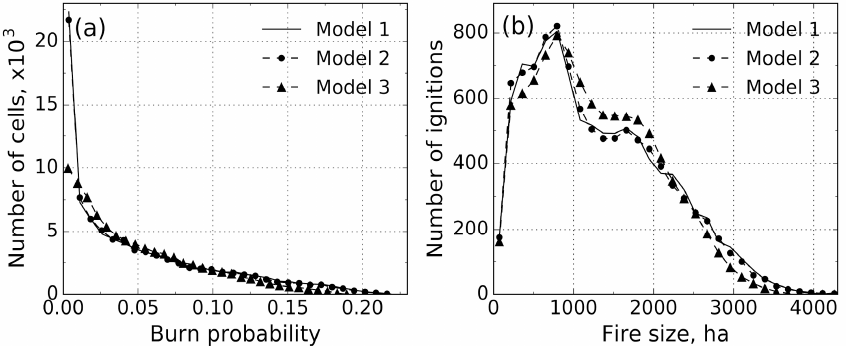
Figure 5. Distribution of ( a ) conditional burn probability, and ( b ) fire size for Model 1, Model 2, and Model 3. Note that the conditional burn probability shown for Model 2 and Model 3 is the average of 100 runs, and the number of ignitions is the average frequency of the 100 runs within each fire size bin.